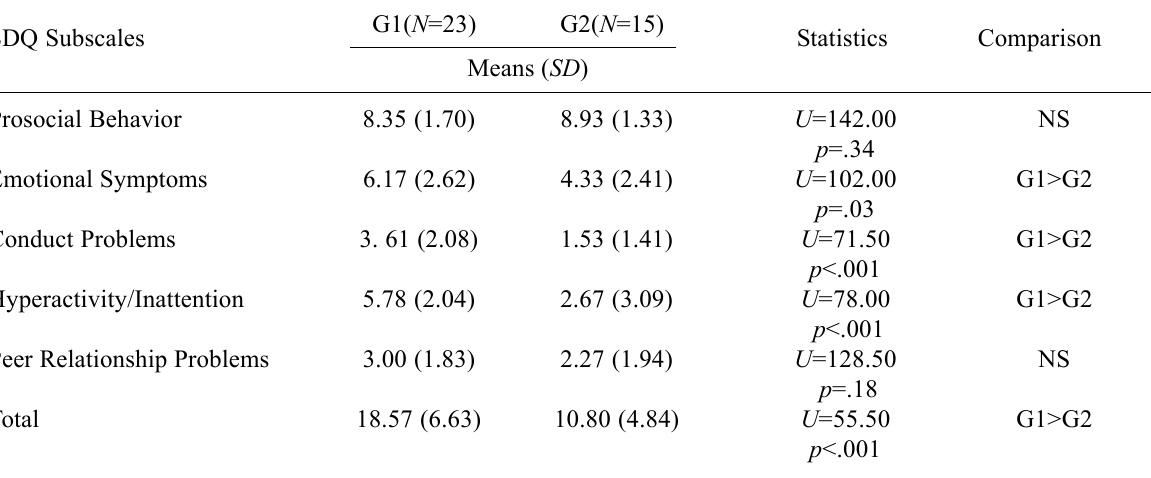
Means and Standard-deviations of Children’s Scores on the SDQ and its Subscales According to Presence (G1) or Absence (G2) of Behavior and School Performance Difficulties SDQ